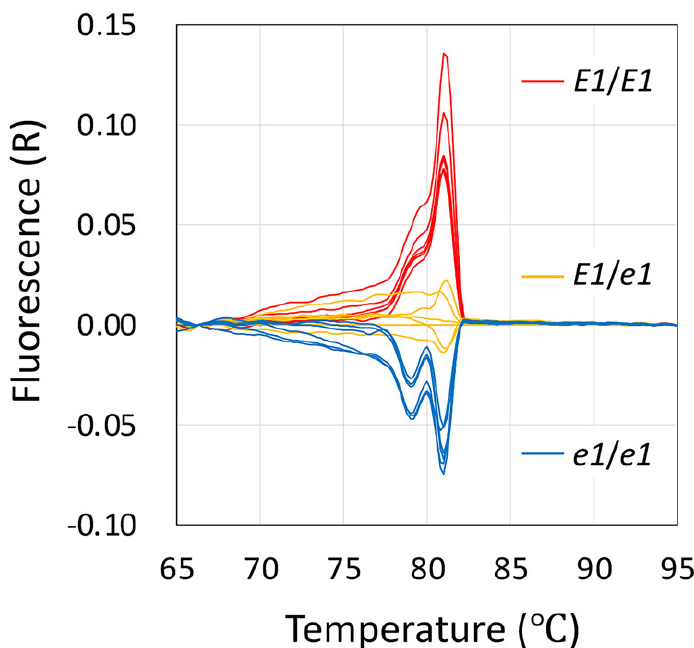
Figure 6. Genotyping of the 17-0040 mutant alleles using HRM analysis. Red indicates results with wild type ( E1 / E1 ) Hiden DNA (n = 6), yellow indicates mixed heterozygous-mimic sample ( E1 / e1 ) using DNA from Hiden and the 17-0040 mutant (n = 6), and blue indicates the 17-0040 mutant ( e1 / e1 ) DNA (n = 6).